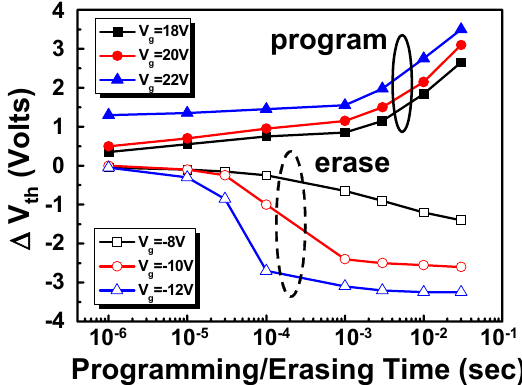
Figure 9. Programming/erasing efficiency characteristics of the ONO-buried oxide poly-Si shift can be larger than 3 V at the adequate operation bias because nanowire FETs. The V th programming/erasing time is approximately 10